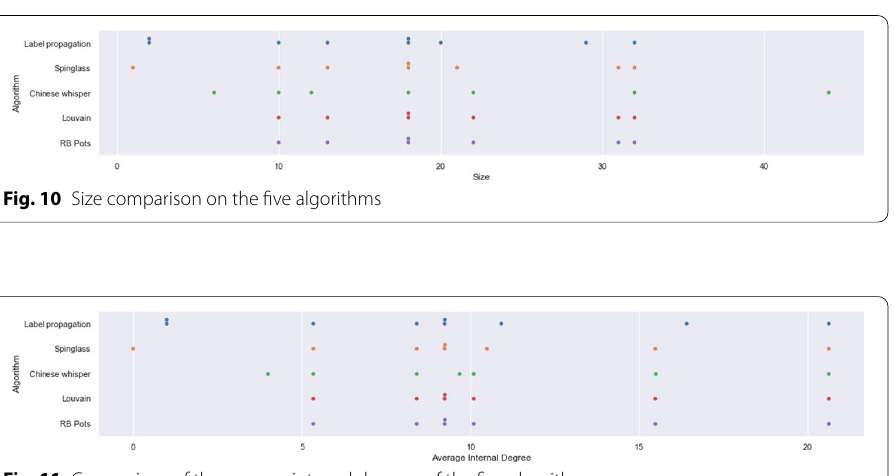
Fig. 11 Comparison of the average internal degrees of the five algorithms